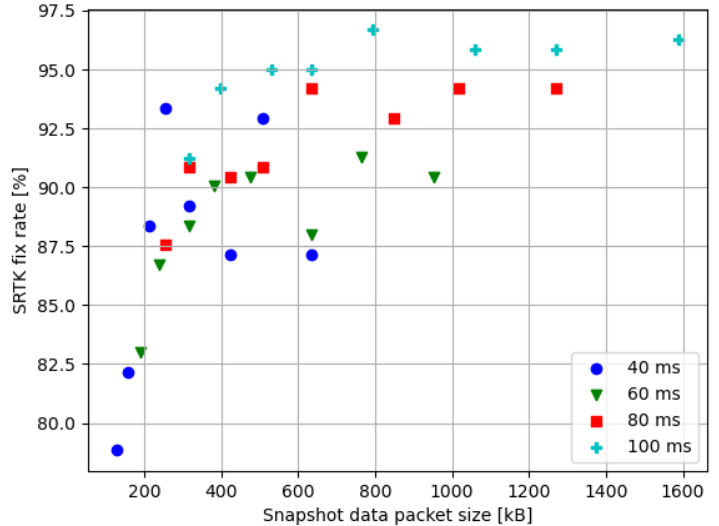
Figure 10. SRTK fix rates in relation to the snapshot sizes at 15 km